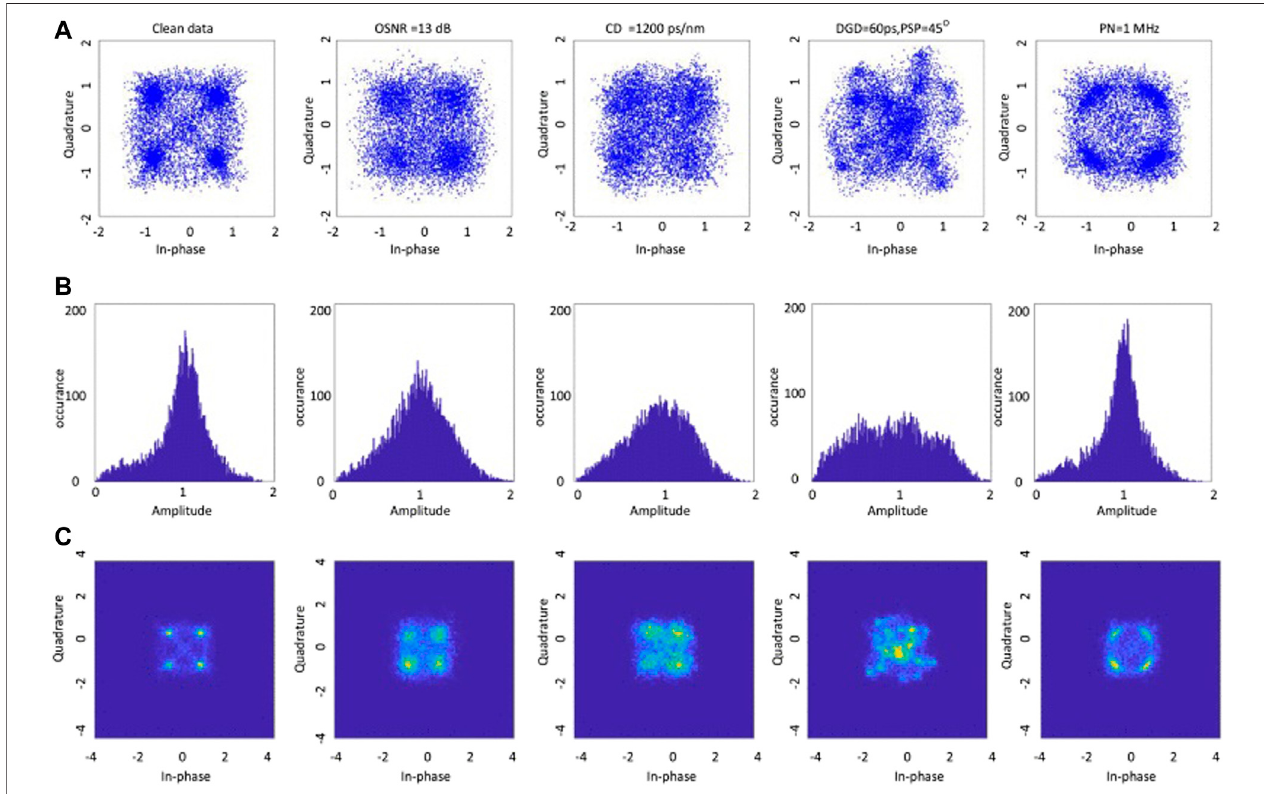
FIGURE 9 | Comparison of constellation diagram, AAH and IQH (Saif et al., 2019).